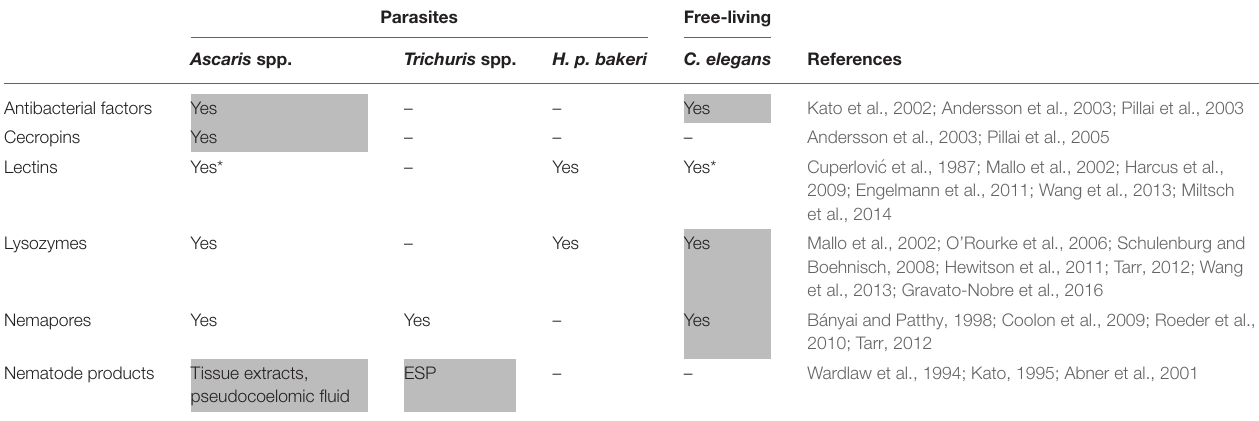
TABLE 3 | Selected antimicrobial molecules of nematodes. Parasites Free-living Ascaris spp. Trichuris spp.